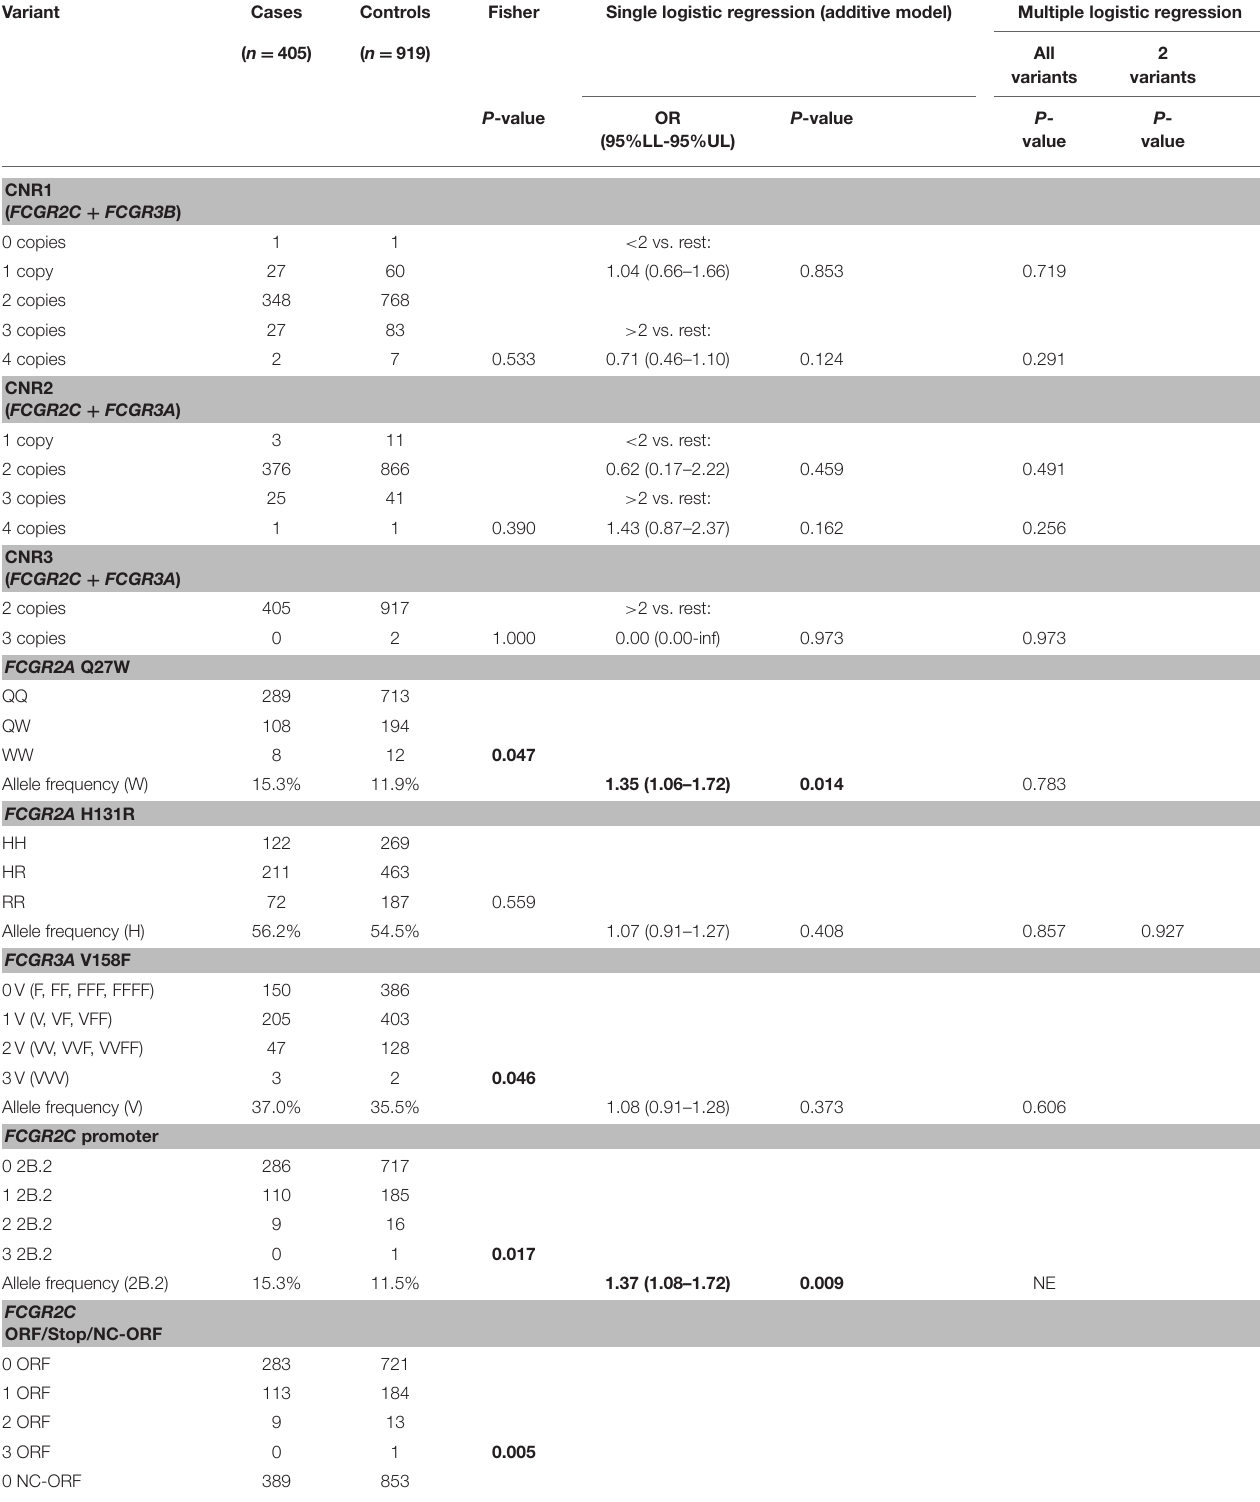
TABLE 2 | Genotype and allele frequencies of functional genetic variants at the FCGR2/3 locus, comparing KD patients of European descent with healthy controls of European descent. Variant